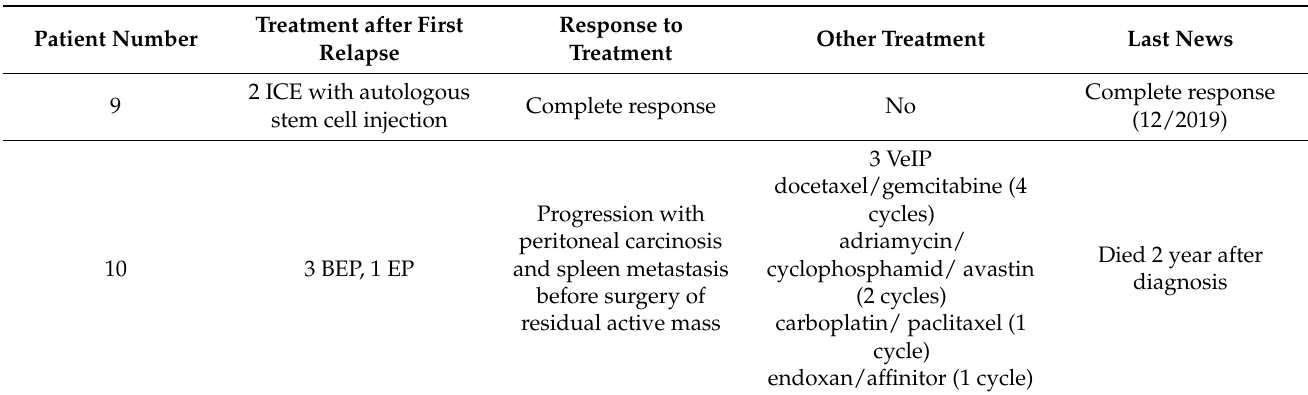
Table 3. Treatment at relapse.